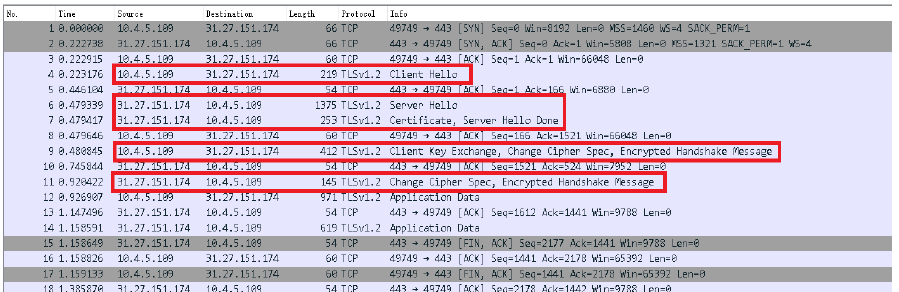
Figure 3. Example of part of a session.